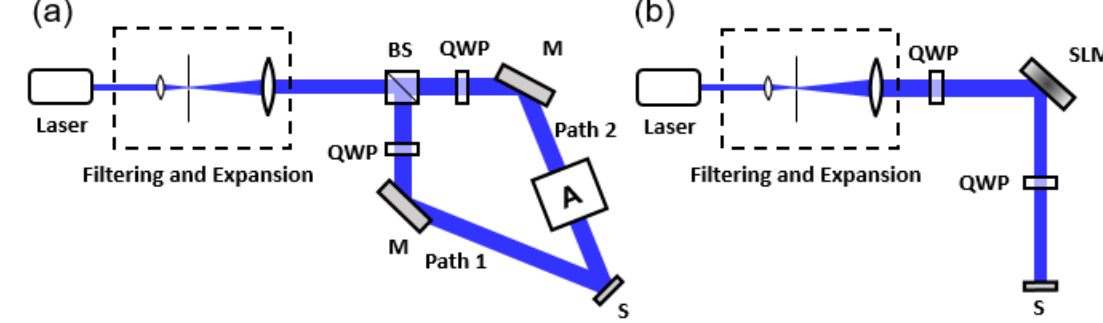
Figure 7. Exposure setups of PVGs. ( a ) Two-beams interferometer. ( b ) Exposure based on SLM.